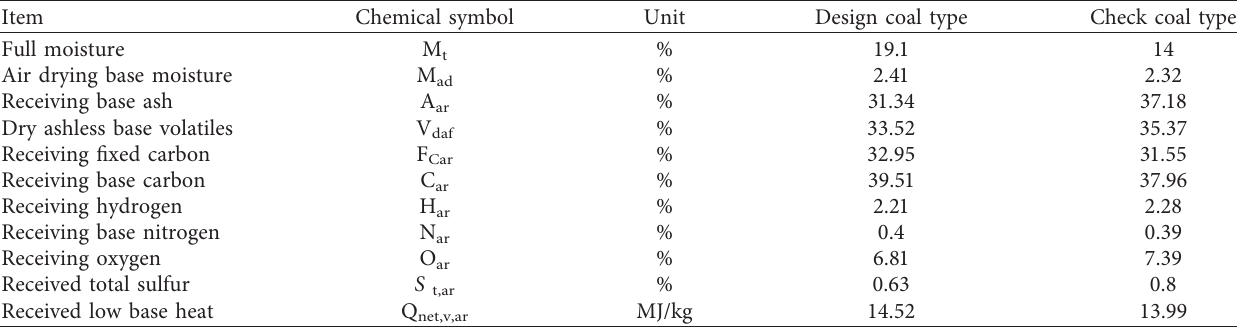
Table 2: CFB boiler burning coal quality data.